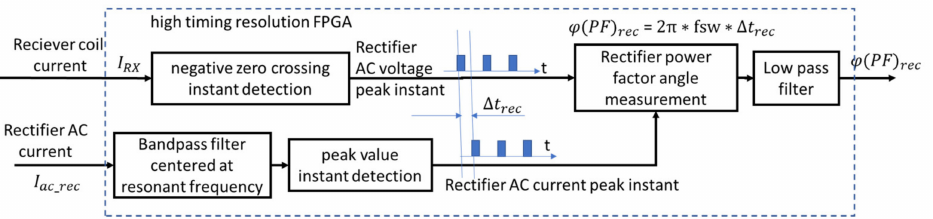
Figure 30. Rectifier AC power factor angle